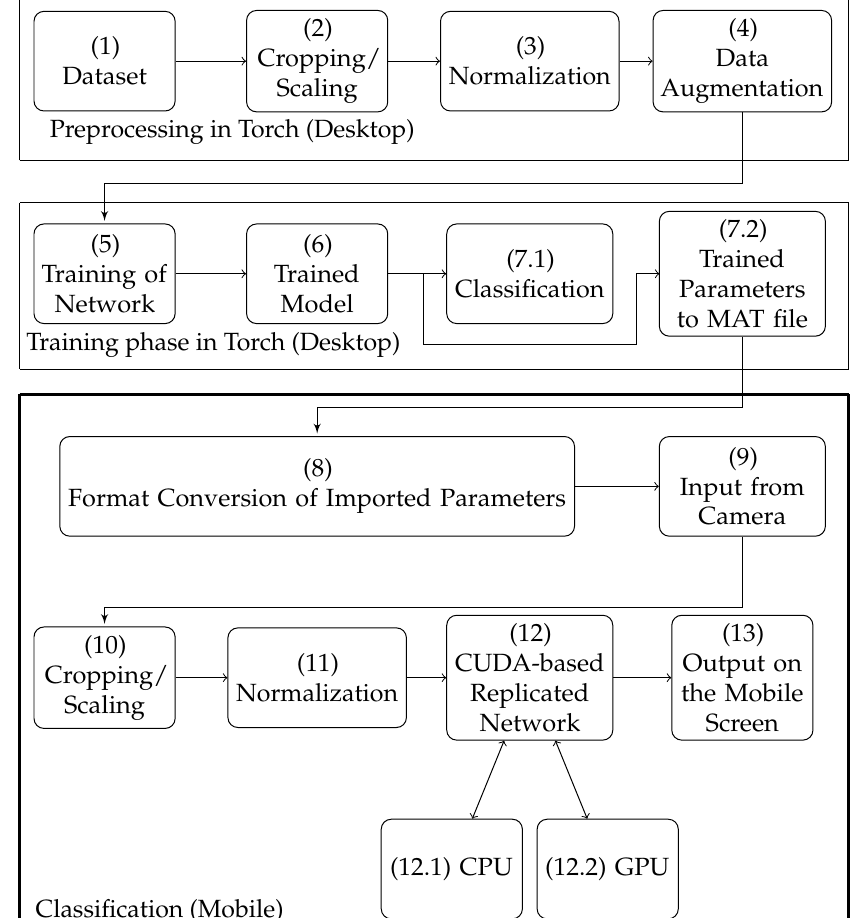
Figure 1. Block diagram of the mobile platform-based deep